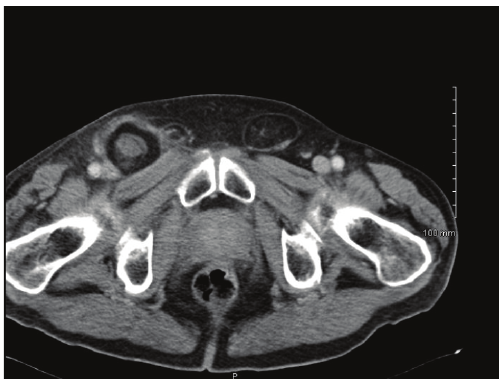
Figure 1: Preoperative CT scan demonstrating incarcerated femoral hernia containing a perforated